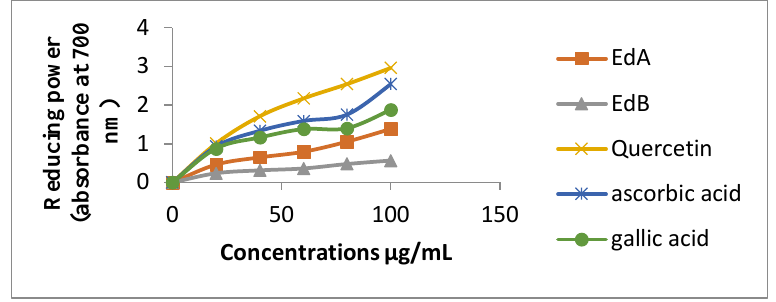
Figure 4. Reducing power of E. dendroides extracts and the standards at different concentrations.